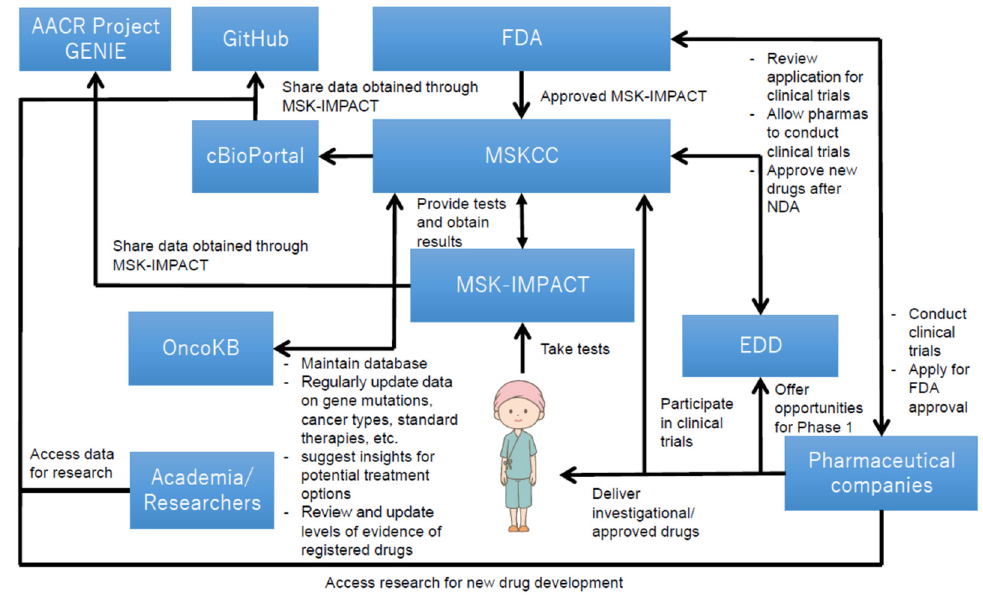
Figure 3. Key technological assets and their relationship in MSK-IMPACT [36,45,46]. Overall,